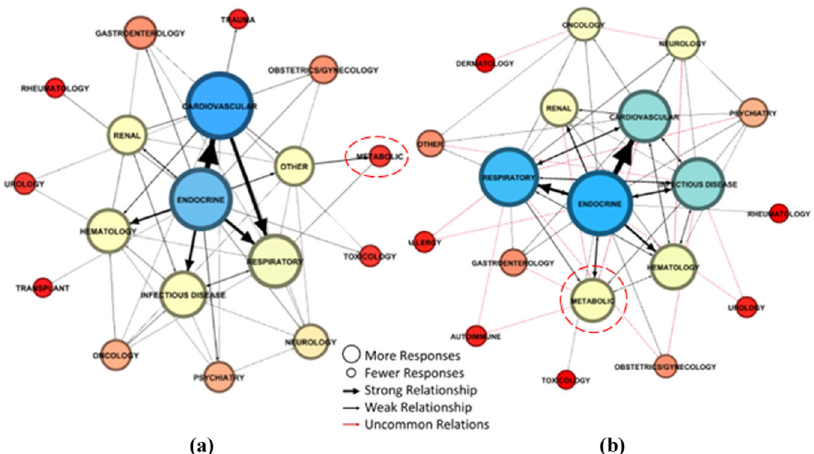
Fig. 3 Network analysis of healthcare professional perceptions of the conditions for which POCTs could help them monitor or manage a disease. a Before COVID-19, healthcare professionals identi fi ed cardiovascular as the condition for which POCTs was most bene fi cial for monitoring or managing diseases. b During COVID-19, healthcare professionals were more focused on using POCTs to monitor or manage endocrine diseases.